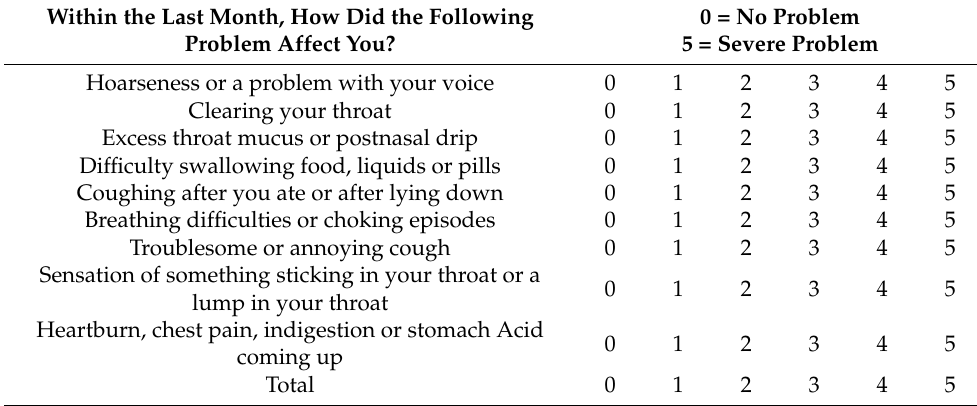
Table 1. Reflux symptom index